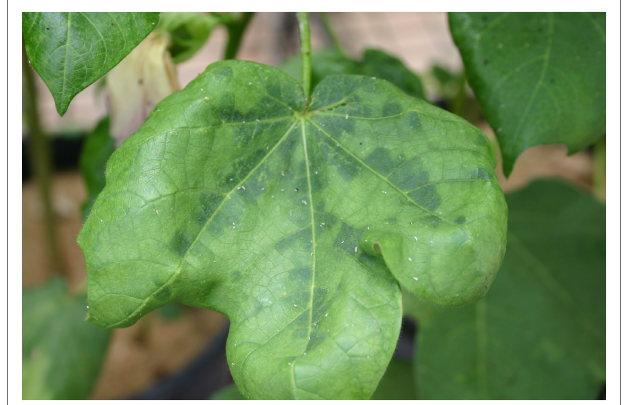
FIGURE 3 | Susceptible (A) and resistant (B) two-spotted spider mite (TSSM) cotton germplasm from the CSIRO cotton breeding program after infestation with TSSM (Photos: Lucy